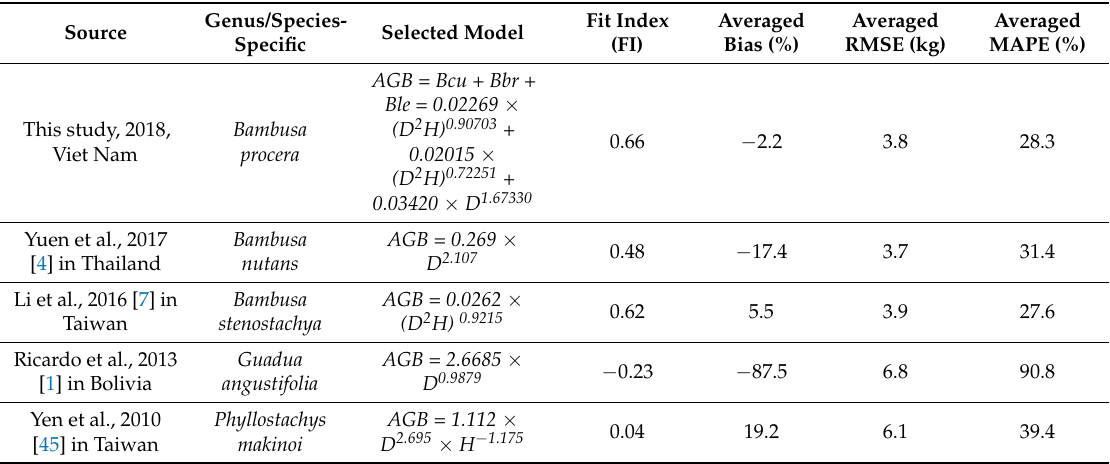
Table 6. Cross validation of AGB model fitted by SUR of this study and other AGB models worldwide with the different/same